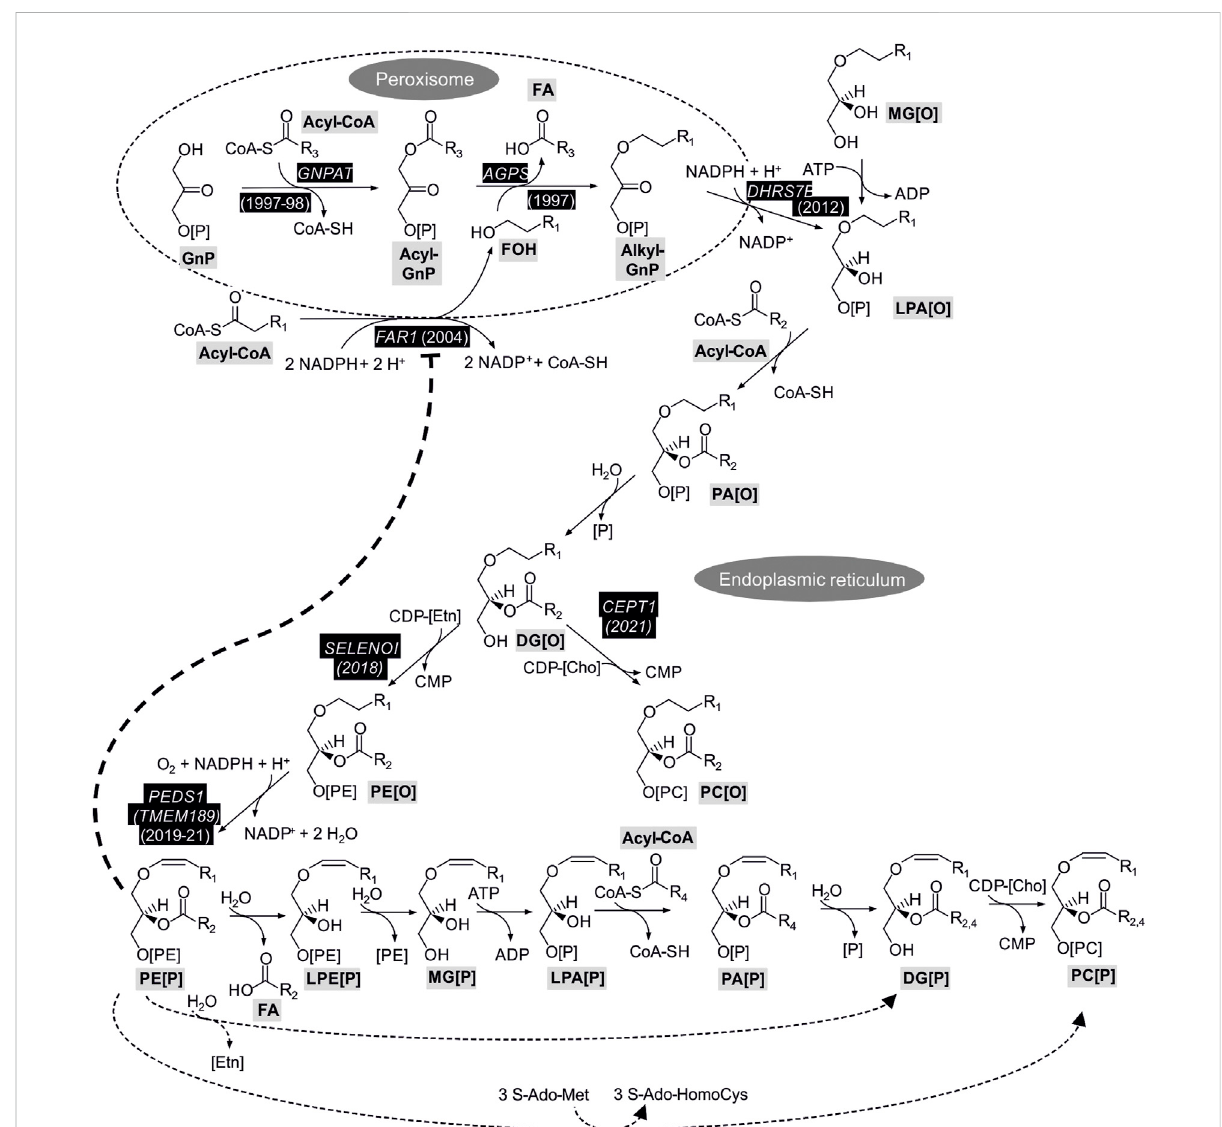
FIGURE 1 Enzymatic reactions and coding genes with con fi rmed role for plasmalogen biosynthesis. Gene symbols shown in white on black background indicategeneswithexperimentalevidenceforaroleinplasmalogenbiosynthesiswiththeyearofpublicationofcloningorsequenceassignment.For the steps without a gene assignment it is not clear to what extent genes catalyzing the reactions for ester (diacyl) lipids are also important for ether lipids.ThebolddottedlineindicatesthefeedbackinhibitionofplasmalogensonFAR1proteinstabilitywhichisdetailedinadedicatedparagraph in chapter 3.1.2 Regulation of plasmalogen biosynthesis . The dotted lines in the bottom of the Figure represent routes of biosynthesis alternative to the main route connected by continuous lines. 1-O-Alkenyl-2-acyl-sn-glycerol (DG[P]) and PC[P] carry different side chains at sn-2 (R2 or R4) depending on the route taken from PE[P] (see text for details). The abbreviations of the metabolites follow the guidelines suggested for shorthand notation of mass spectrometry-derived lipid structures (Liebisch et al., 2020). Cho, choline; Etn, ethanolamine; FA, fatty acid; FOH, fatty alcohol; S-AdoMet, S-adenosyl-methionine; S-Ado-HomoCys,